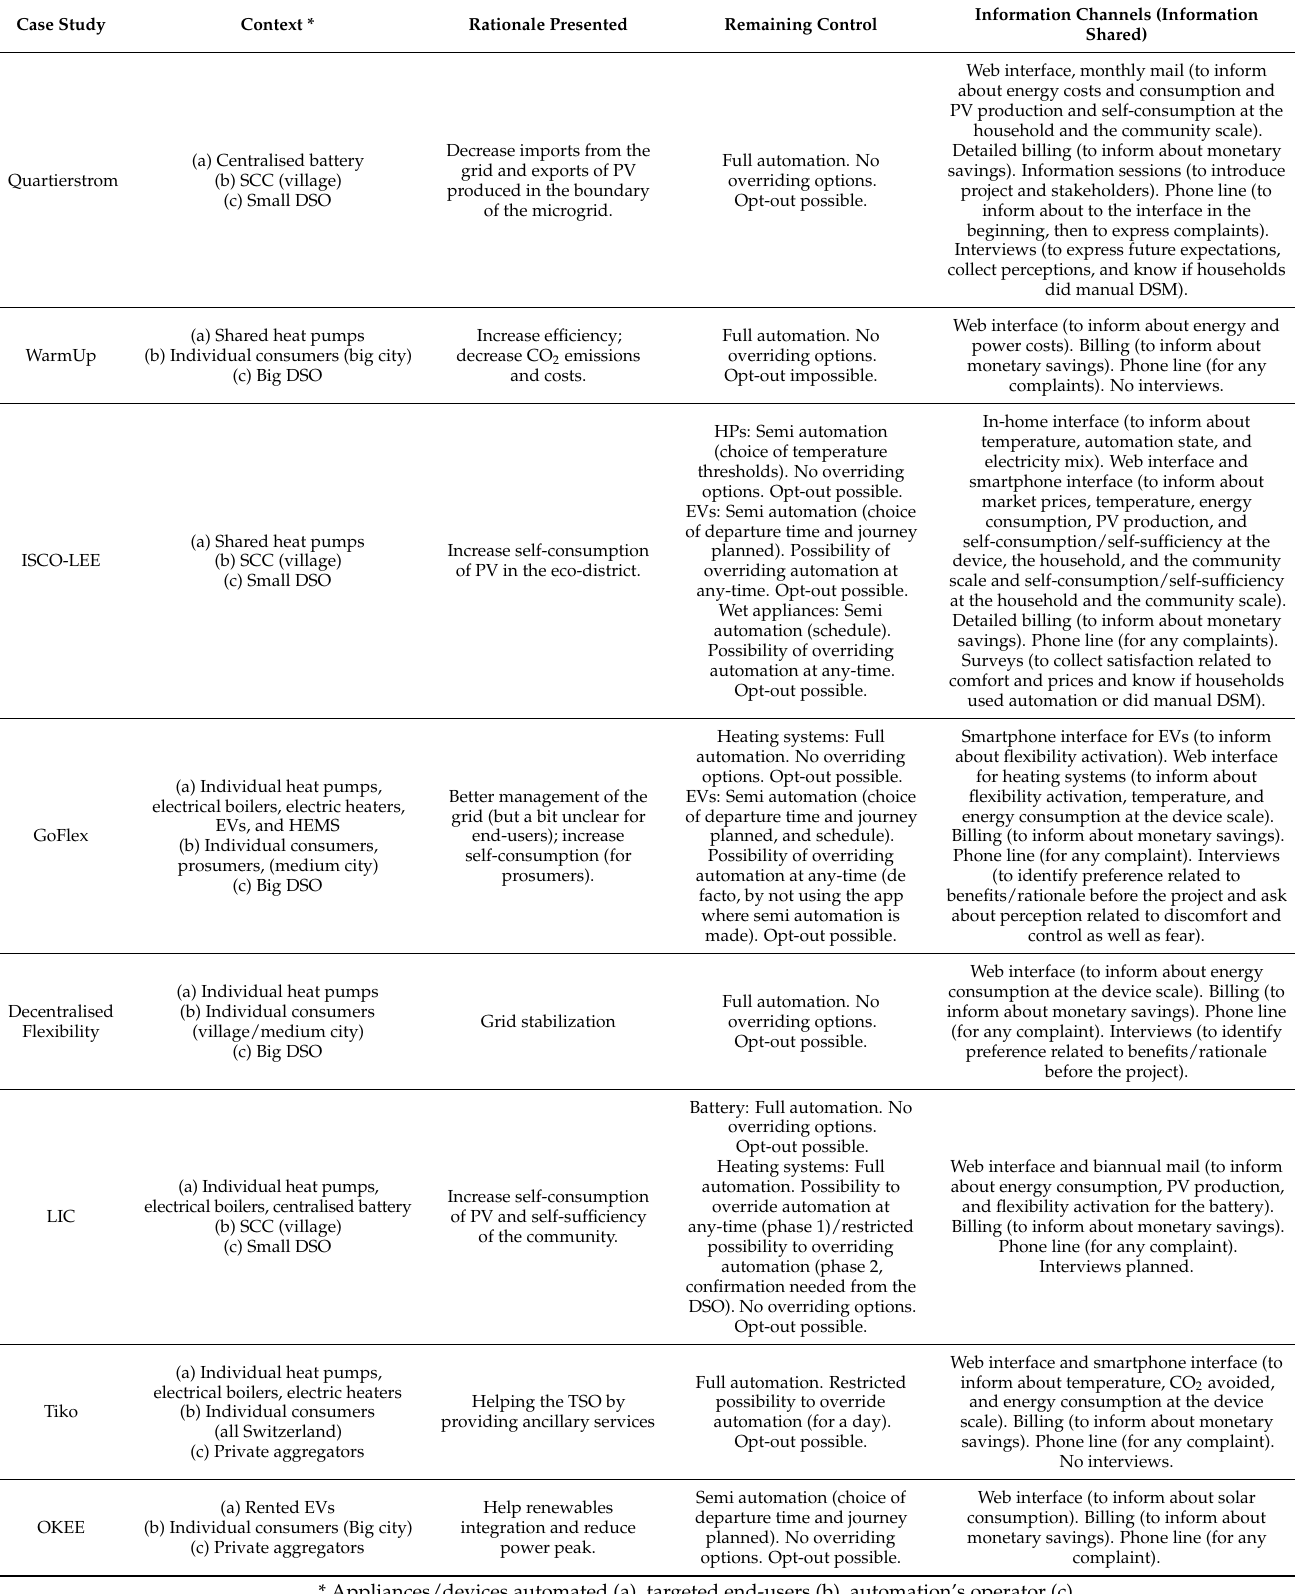
Table 4. Benefits and incentives presented to the